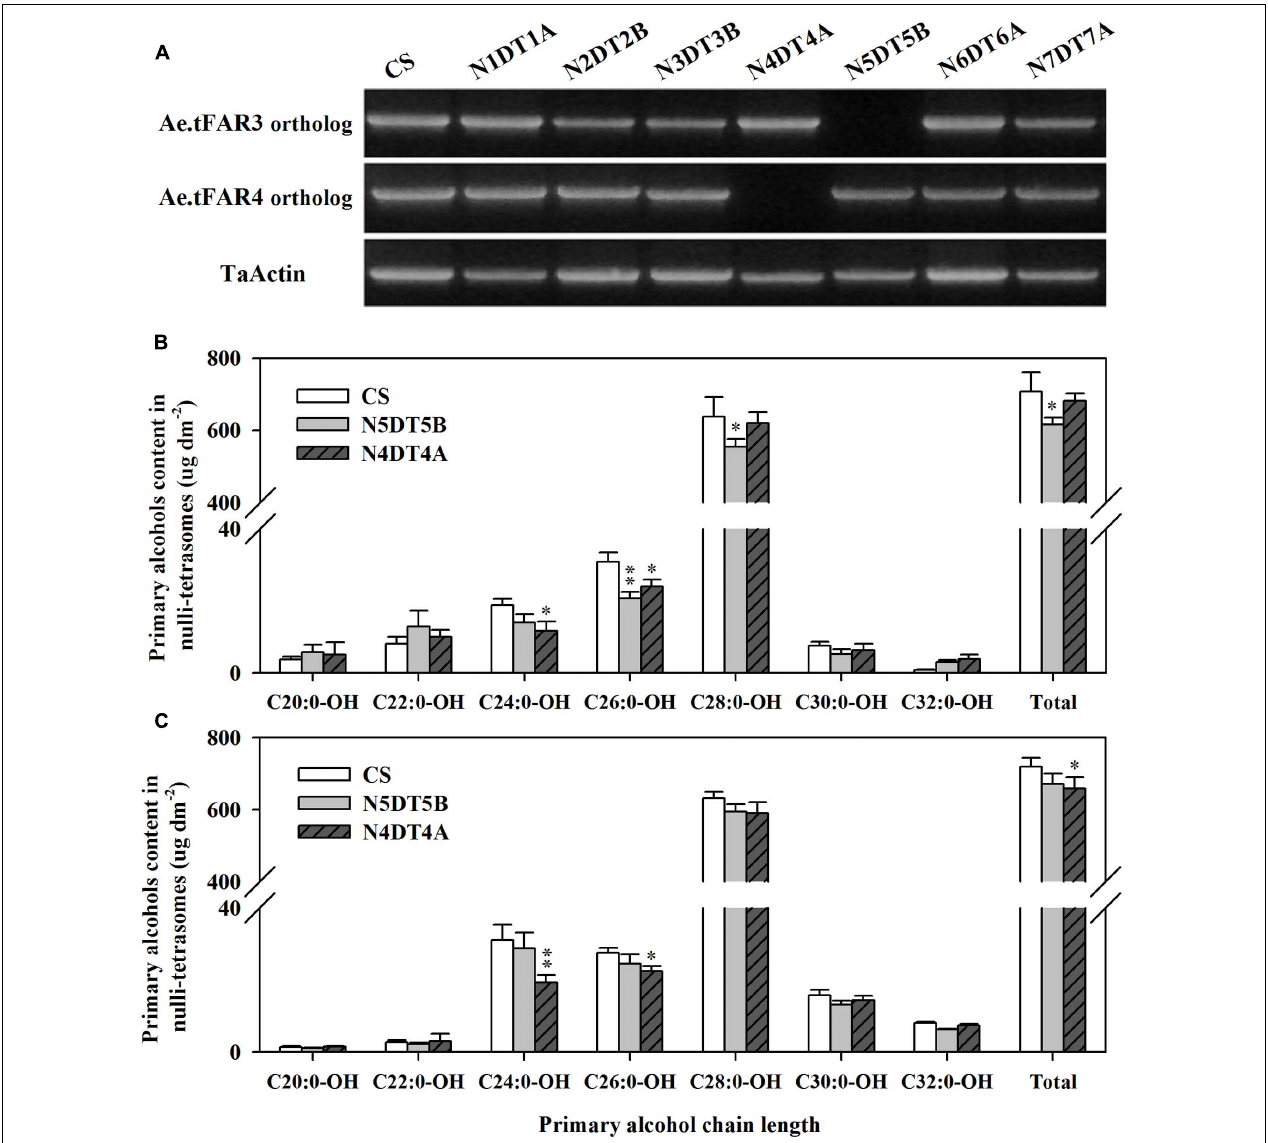
FIGURE 7 | Chromosomal localization of Ae.tFAR paralogs and primary alcohol profiles of wheat nullisomic lines. (A) Chromosomal localization of Ae.tFAR paralogs in nullisomic–tetrasomic lines of wheat (cv. CS). N5DT5B and N4BT4A are abbreviations for nullisomic–tetrasomics of common wheat, namely nulli5D–tetra5B and nulli4B–tetra4A, respectively. The coverage and chain length distributions of primary alcohols from (B) seedling leaves and (C) flag leaves in CS and the nullisomic–tetrasomic lines. Each value is the mean of three independent measurements. Error bars indicate SD, and significant differences were assessed according to Student’s t -test ( ∗ for P < 0.05; ∗∗ for P <